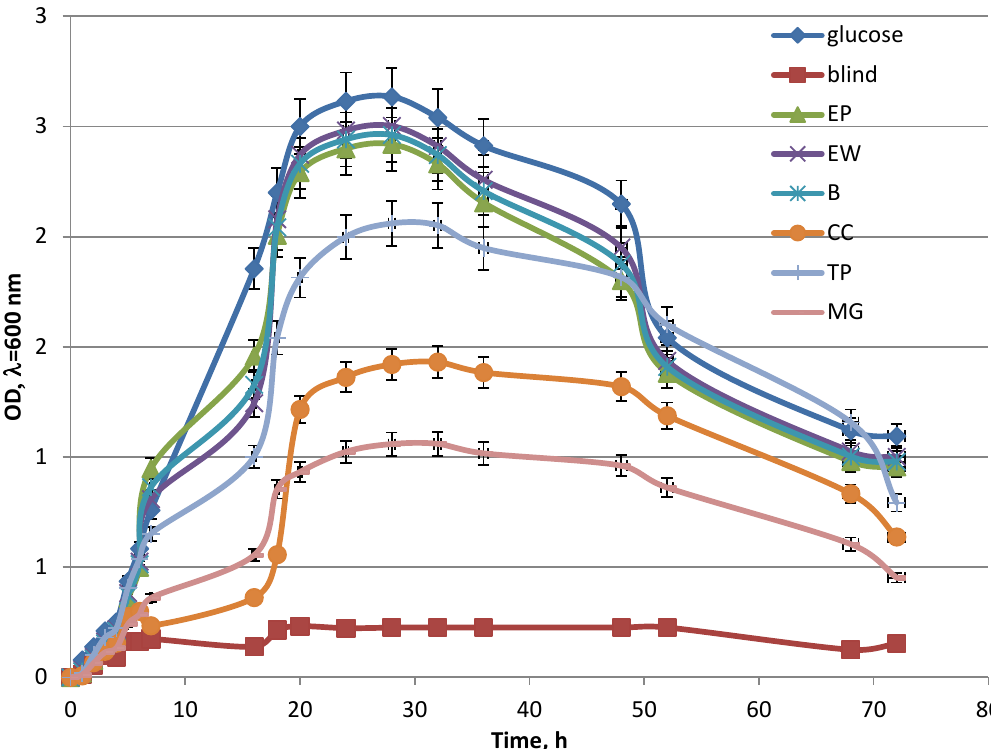
Figure 4. Changes in optical density of Enterobacter aerogenes cultures during dark fermentation for different feed materials.